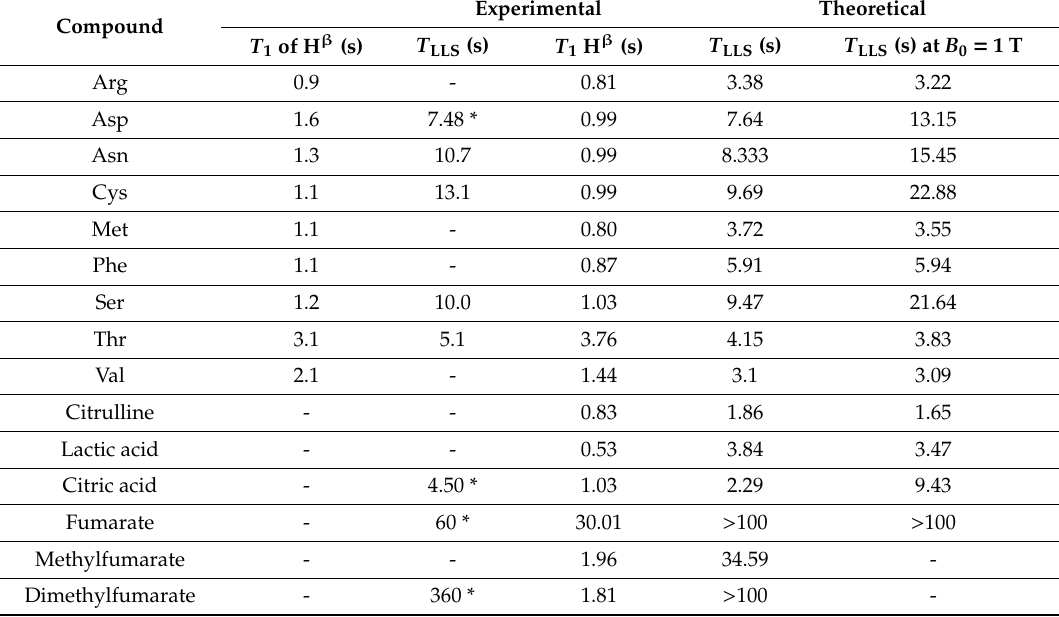
Table 1. T 1 and T LLS for the selected amino acids. The T LLS values were also computed for the case of low magnetic field ( B 0 = 1 T). * Values reported from the available literature [16,19,20] (in some cases the experimental settings were di ff erent to ours).